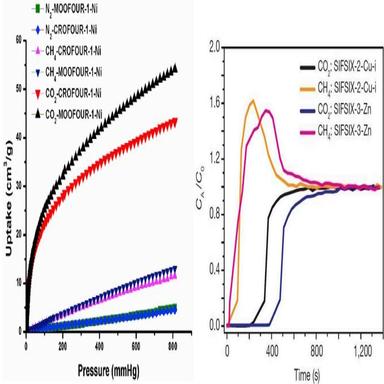
CO2 and CH4 sorption data at 298 K from angular pillared HUMs (left); breakthrough experiments of CO2 and CH4 gas mixture with 50/50 ratio from linear pillared and interpenetrated HUMs.